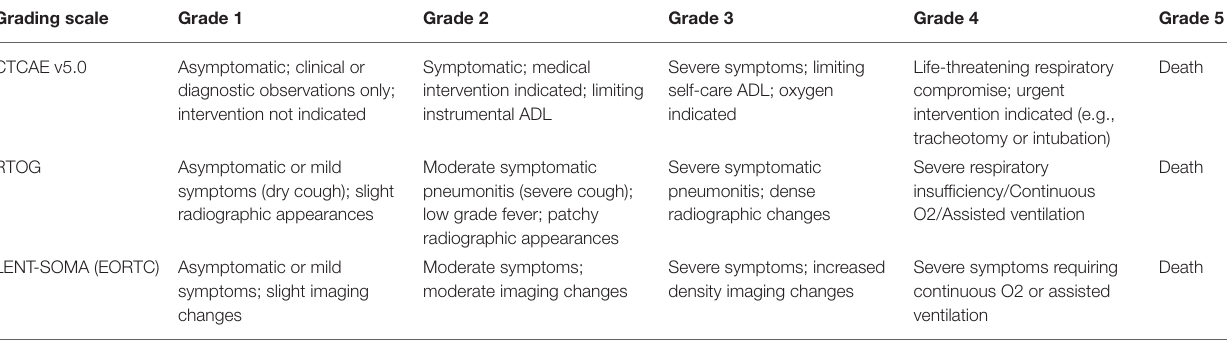
TABLE 1 | Overview about grading scales for radiation-induced pneumonitis. Grading scale